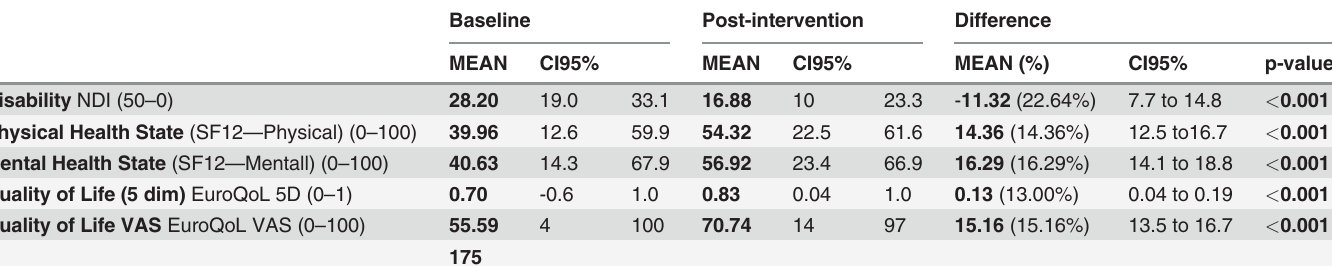
Table 3. Mean differences between the outcomes variables pre- and